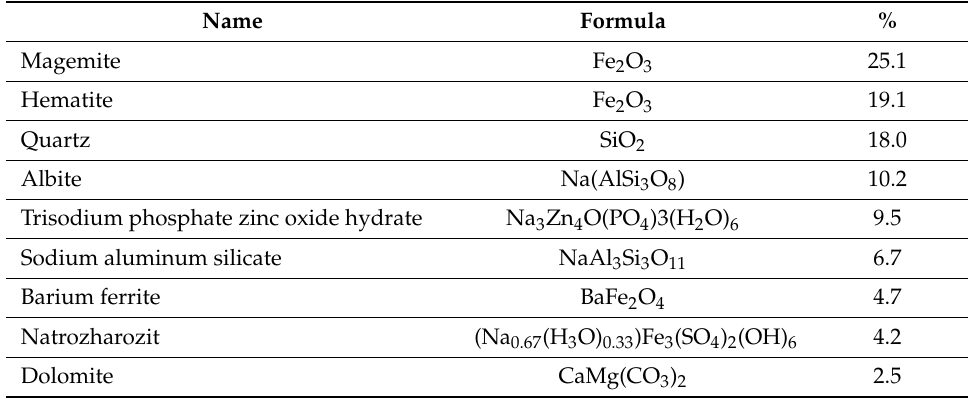
Figure 1. X-ray pa tt ern of the initial sample of pyrite cinders . Figure 1. X-ray pattern of the initial sample of pyrite cinders. Table 1. Phase composition of the initial sample of pyrite cinders. Table 1. Phase composition of the initial sample of pyrite